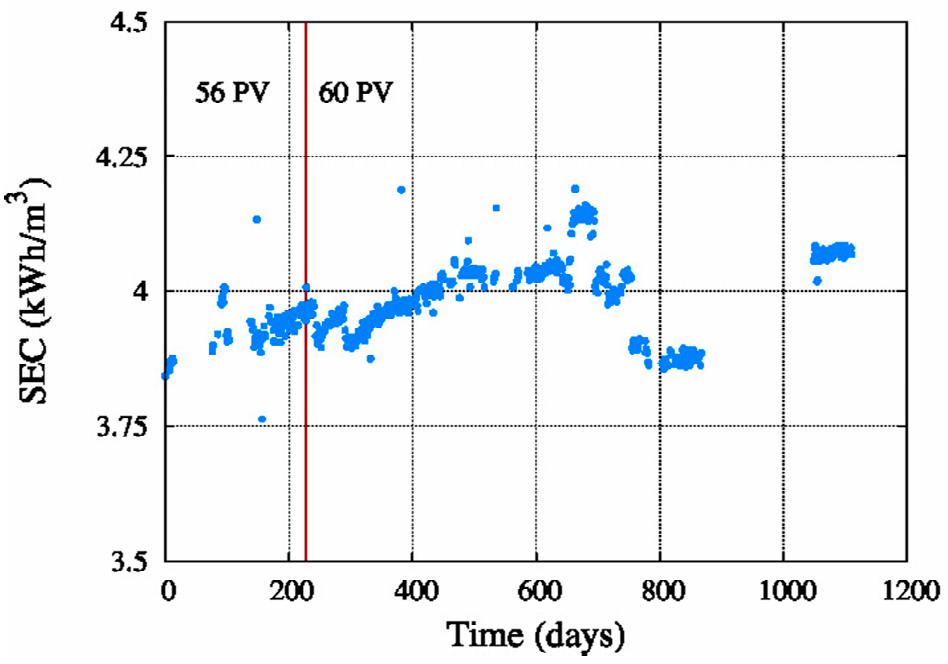
Figure 11. System energy consumption.